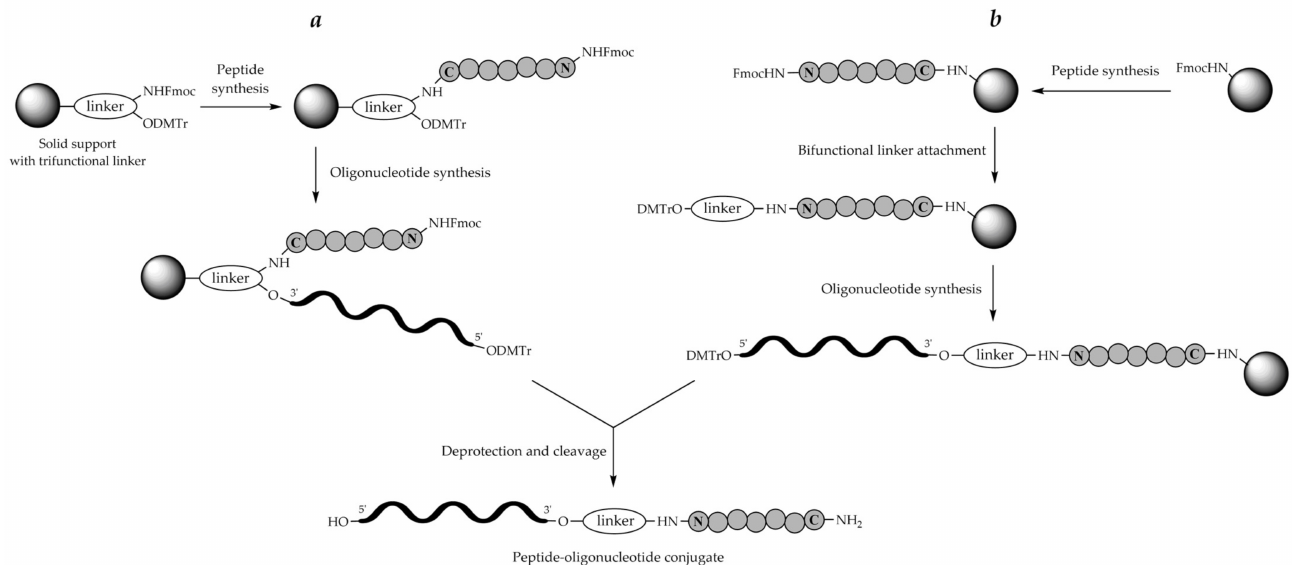
Figure 4. Two main schemes for stepwise solid-phase synthesis of POCs: ( a ) with a branched trifunctional linker and ( b ) with a bifunctional linker. Note: The oligonucleotide fragment can be assembled first, followed by the peptide fragment. DMTr—4,4 (cid:48) -dimethoxytrityl group; Fmoc—9-fluorenylmethoxycarbonyl group; C and N—peptidic C- and N-termini,